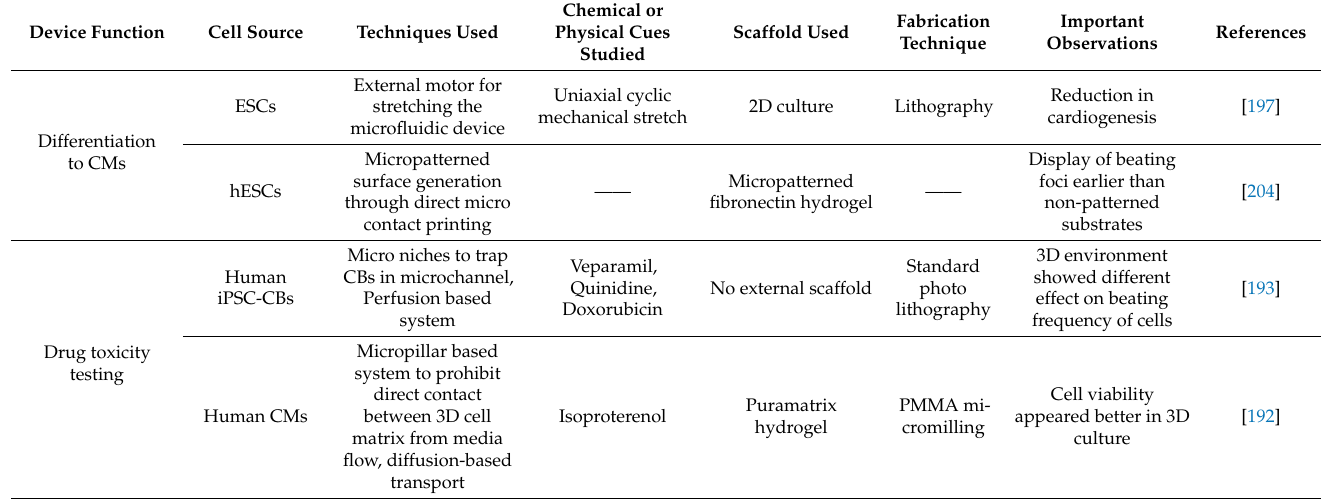
Table 3. Use of microfluidics platforms in the study of various aspects of CVD, and applications in cardiac tissue engineering. Device